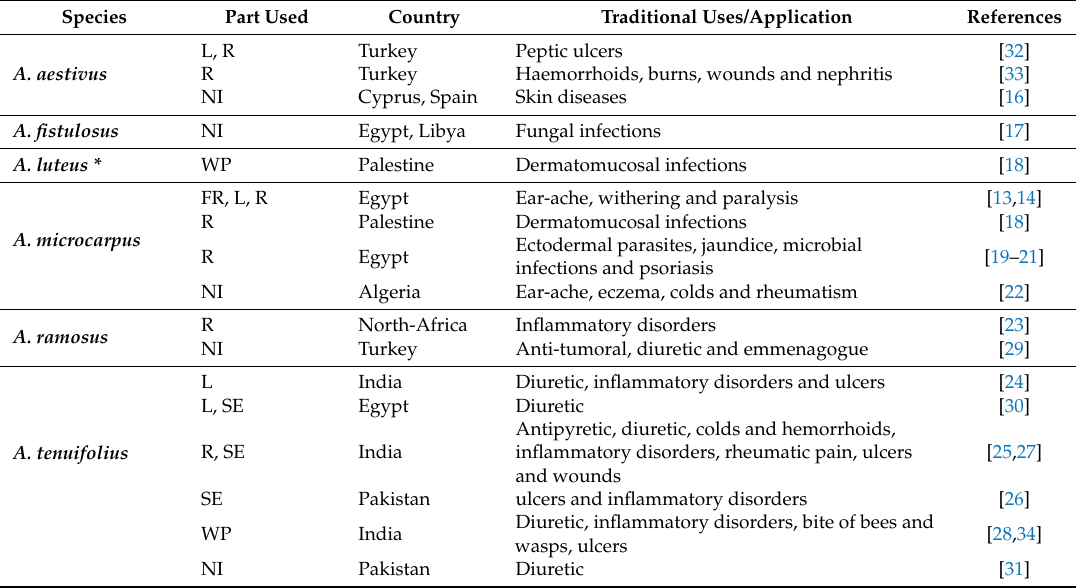
Table 1. Ethnomedicinal uses of the Asphodelus